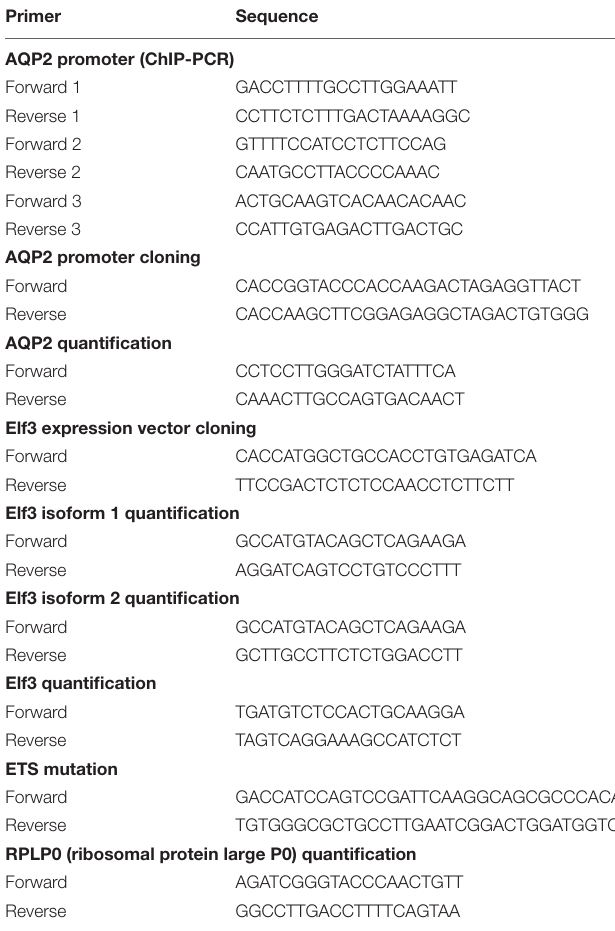
TABLE 1 | Oligonucleotide primers used in this